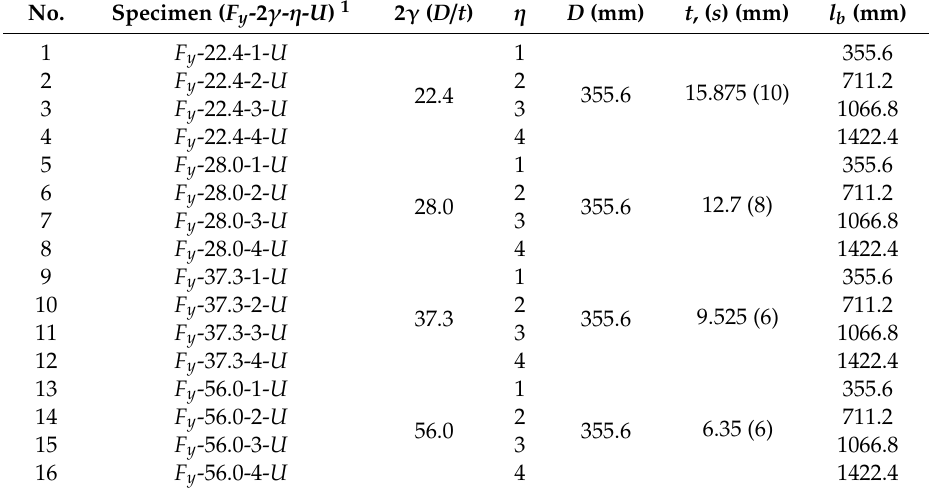
Table 7. Parameters for CHS XP-joints made of HSB600, HSA800, S900, and S1100 steel.